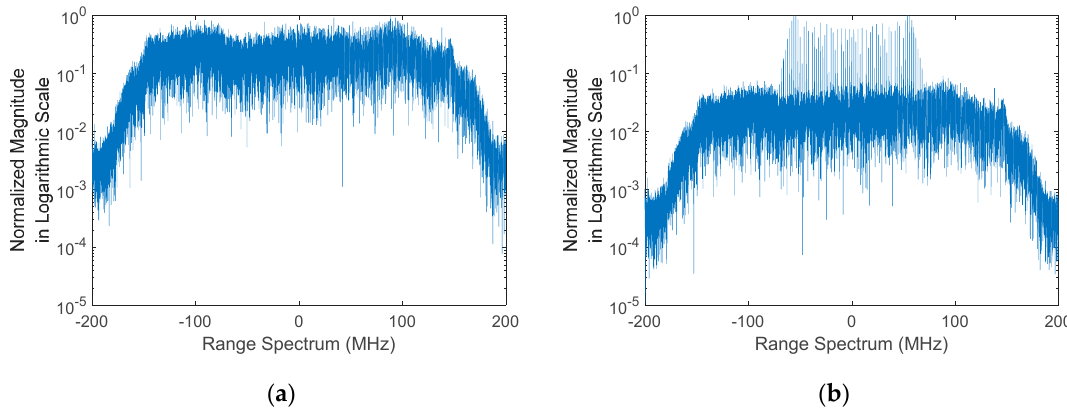
Figure 2. A particular example: the range spectrum of the synthetic aperture radar (SAR) echoes ( a ) without RFI and ( b ) with RFI.